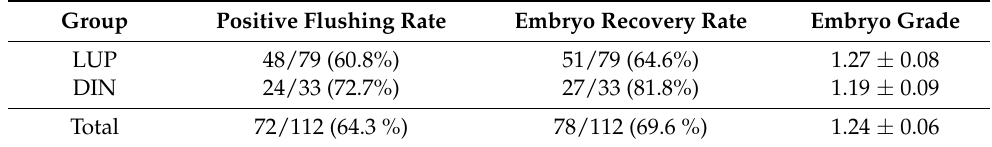
Table 4. Embryo recovery rate (ERR), positive flushing rate (PFR) and embryo morphological grade (EG, 1–4) for the luprostiol (LUP) and dinoprost tromethamine (DIN) groups. Group Positive Flushing Rate Embryo Recovery Rate Embryo Grade LUP 48/79 (60.8%) 51/79 (64.6%) 1.27 ± 0.08 DIN 24/33 (72.7%) 27/33 (81.8%) 1.19 ± 0.09 Total 72/112 (64.3 %) 78/112 (69.6 %) 1.24 ± 0.06